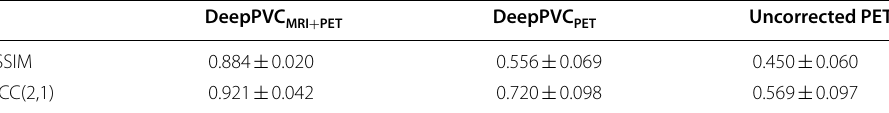
Each value indicates the mean standard deviation of the 156 subjects pooled from the six cross‑validation datasets. ± ICC , intraclass correlation coefficient; SSIM , structural similarity